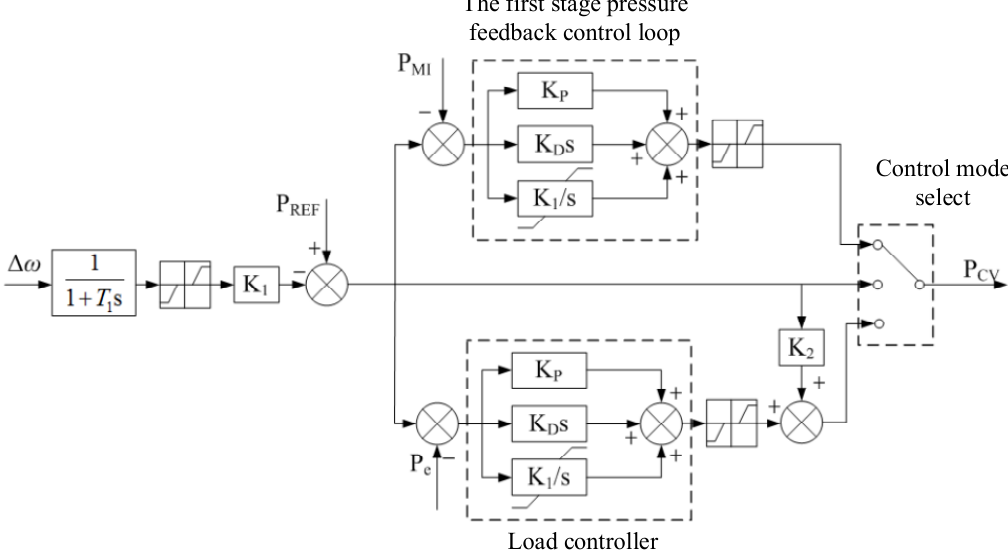
Figure 10. Traditional model of speed governor.